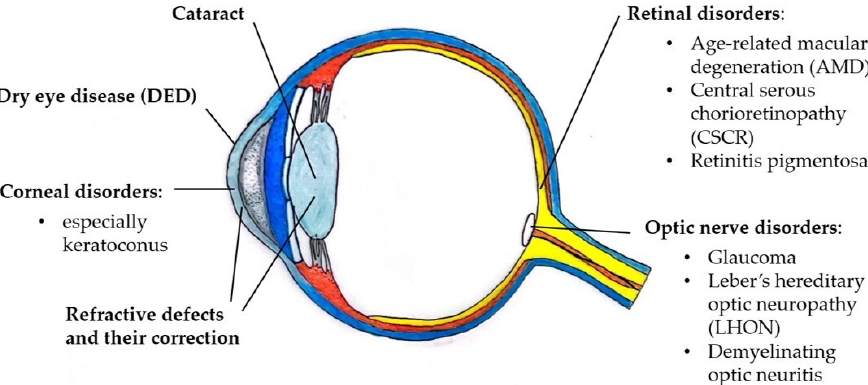
Figure 1. Drawing presenting the ocular disorders influenced by sex hormones. Courtesy of Dr. Sara Salomone, University of Turin, Italy. Table 1. Evidence of a role of sex hormones on the pathophysiology of ocular disorders. ± = no significant evidence, + = weak evidence, ++ = strong evidence.